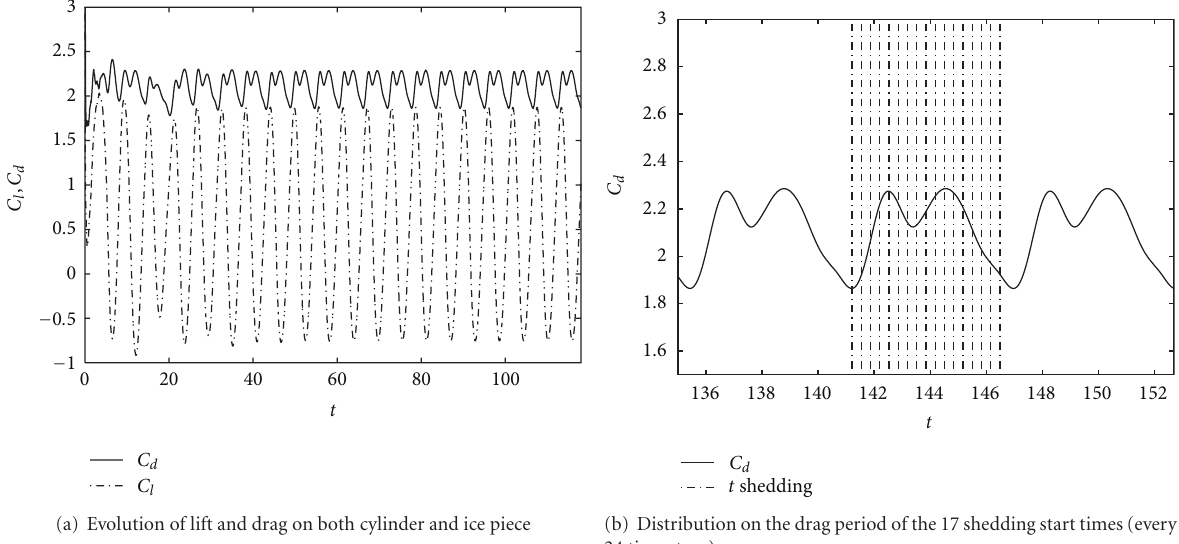
Figure 7: Lift and drag coe ffi cients around the iced cylinder.